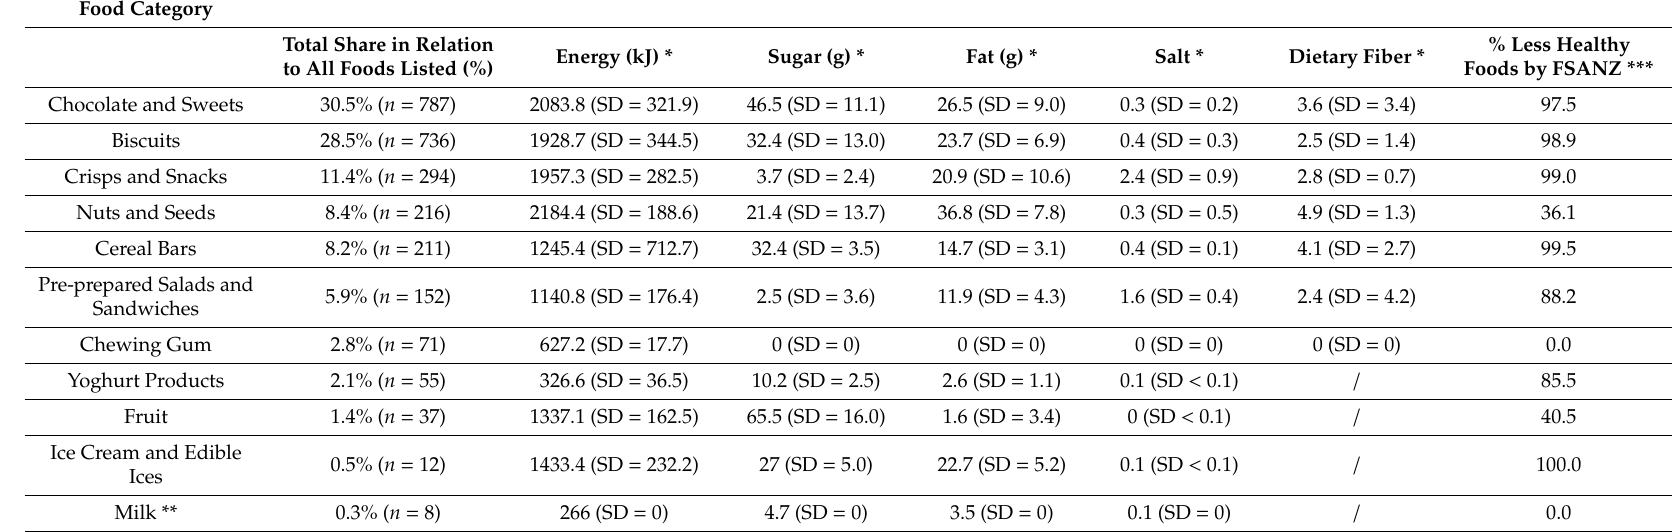
Table 3. Nutritional assessment of foods displayed in vending machines in health and social care institutions ( n = 2534) according to food categories. Food